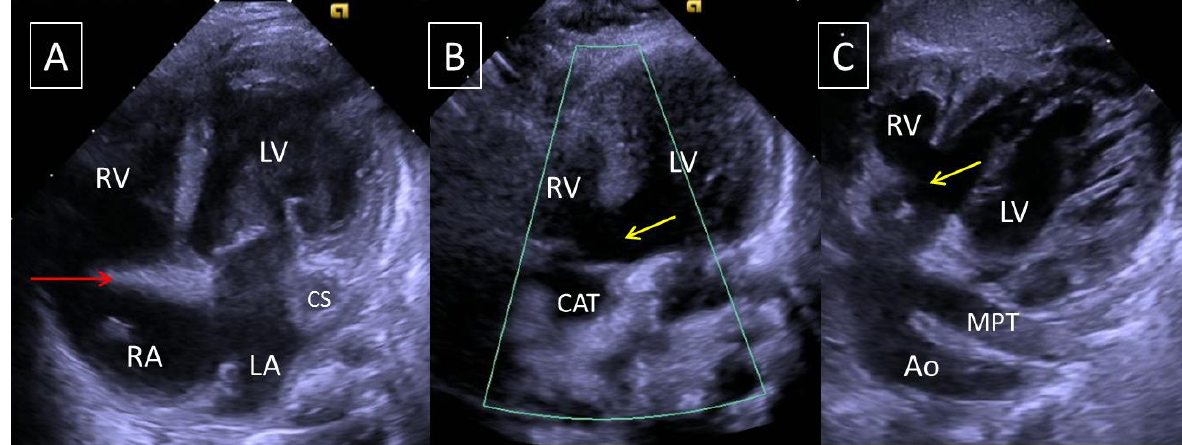
Figure 2. Case 39 (Table 2) with tricuspid atresia and common arterial trunk type 1: echocardiographic views. 2 A : Four-chamber apical view. Red arrow: absence of right atrioventricular connection (tricuspid atresia). CS, dilated coronary sinus; LA, left atrium; LV, left ventricle; RA, right atrium; RV, right ventricle. 2 B : Five-chamber apical view. The common arterial trunk overrides the ventricular septum, above a large outlet ventricular septal defect (yellow arrow). CAT, common arterial trunk; LV, left ventricle; RV, right ventricle. 2 C : Subcostal view. Common arterial trunk type 1. Yellow arrow, outlet VSD; Large outlet VSD. Ao: Aorta; MPT: Main pulmonary trunk.